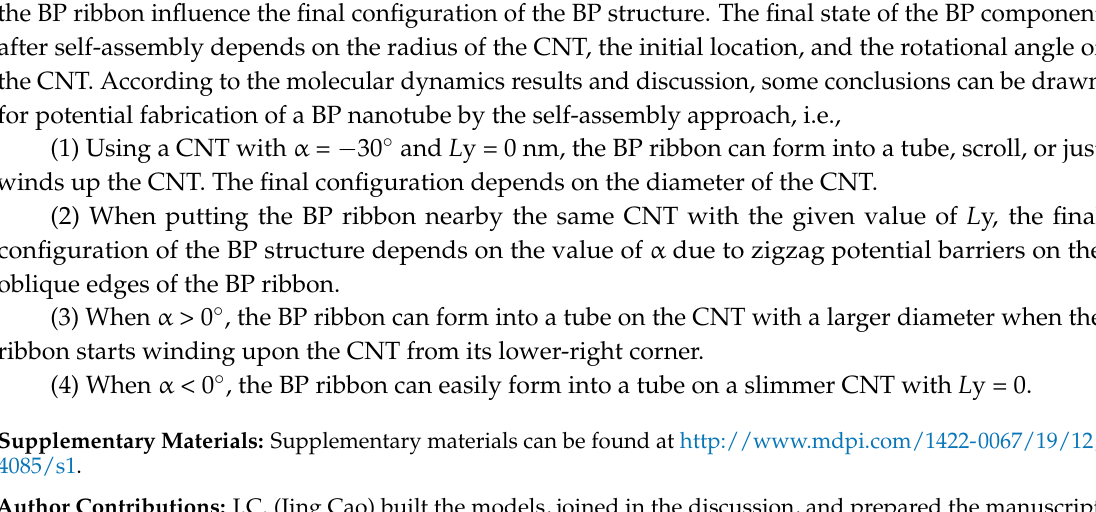
Figure 11. Major steps in an MD simulation.